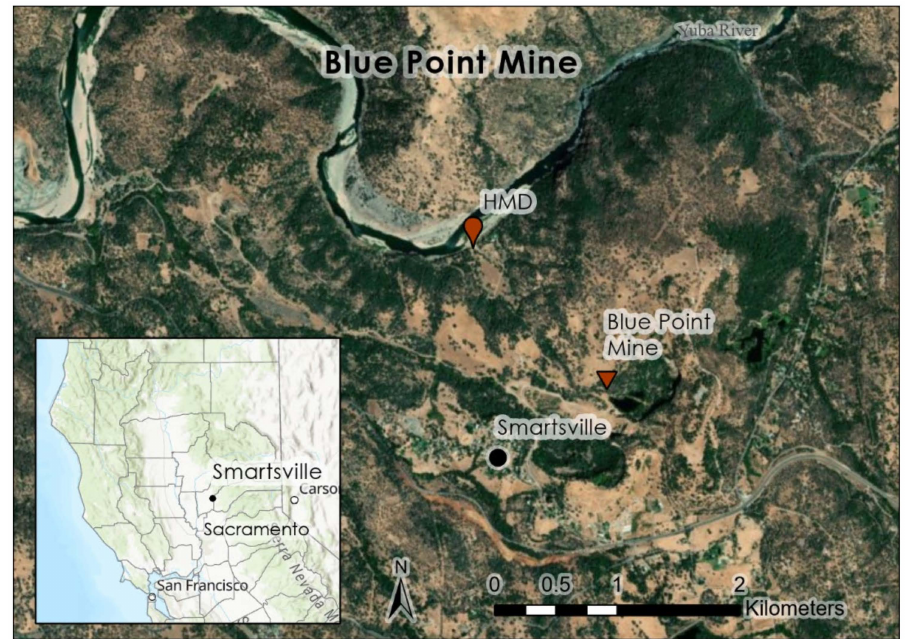
Figure 2. Map of Blue Point Mine. Located in Yuba County, CA. Hydraulic mine debris discharged from Blue Point was collected in October